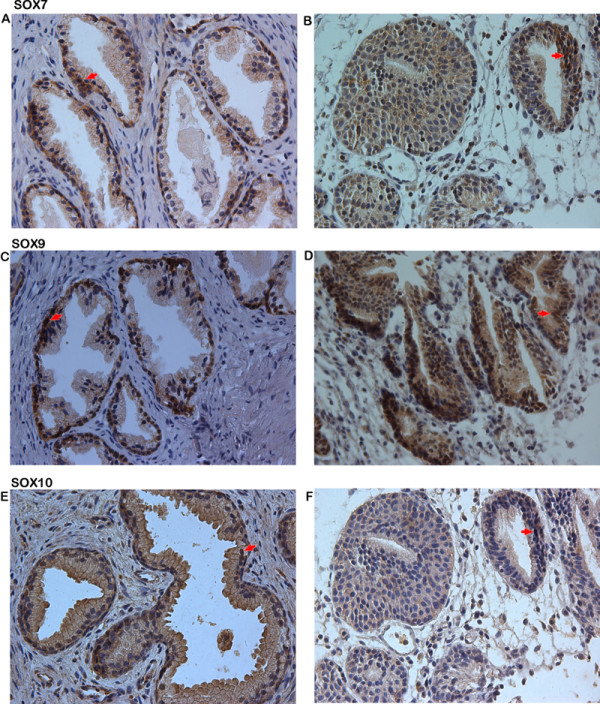
Immunohistochemical staining for SOX7, SOX9 and SOX10 in PCa (Original magnification × 200). a, SOX7 strongly positive staining was found in cytoplasm of Benign tissue; b, SOX7 weakly positive staining in PCa was found in cytoplasm of PCa tissues; c, SOX9 weakly positive staining was found in nucleus of Benign tissue; d, SOX9 strongly positive staining in PCa was found in nucleus of PCa tissues; e, SOX10 strongly positive staining was found in cytoplasm of Benign tissue; f, SOX10 weakly positive staining in PCa was found in cytoplasm of PCa tissues.